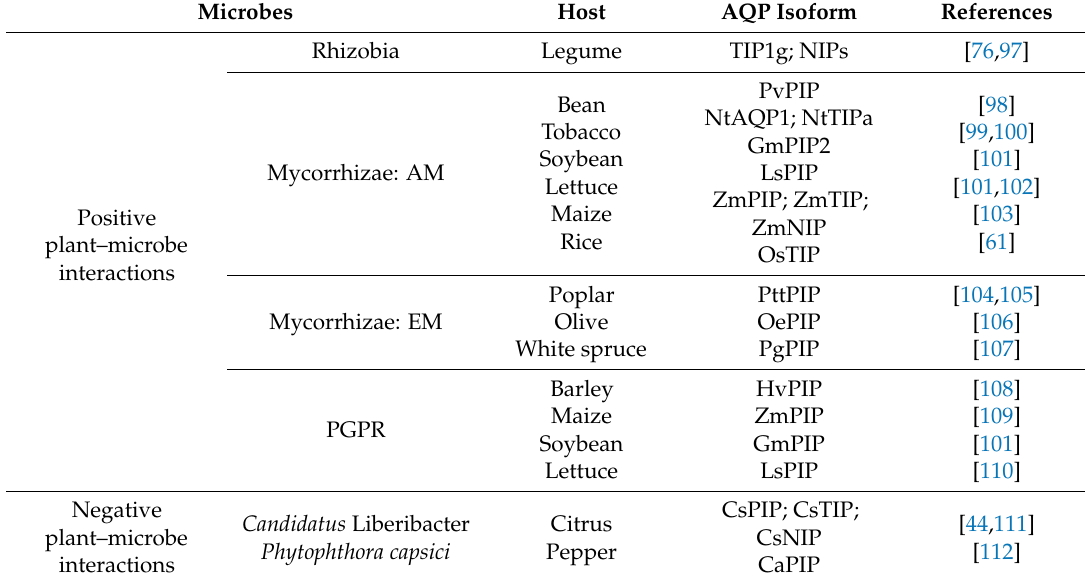
Table 1. Plant aquaporins (AQPs) involved in plant–microbe